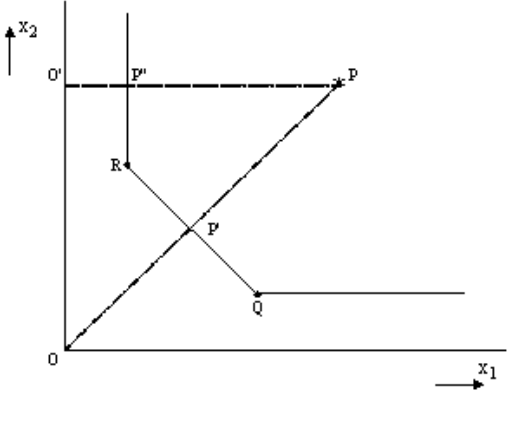
FIGURE 1. Input-oriented DEA